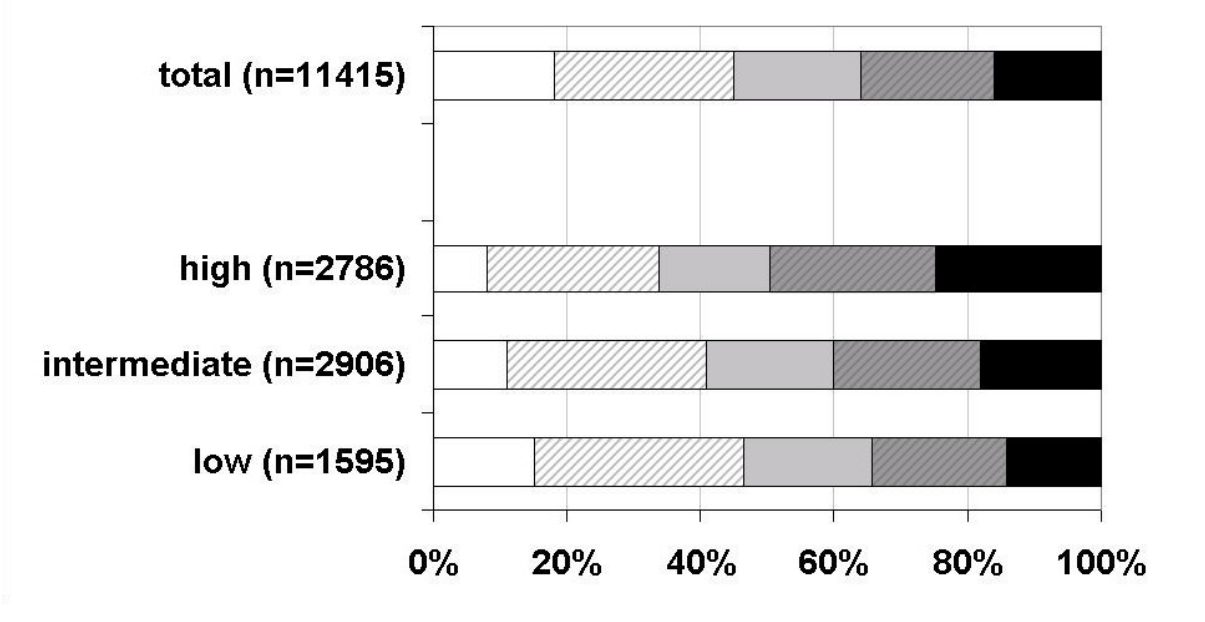
Figure 2. Type of program user by education